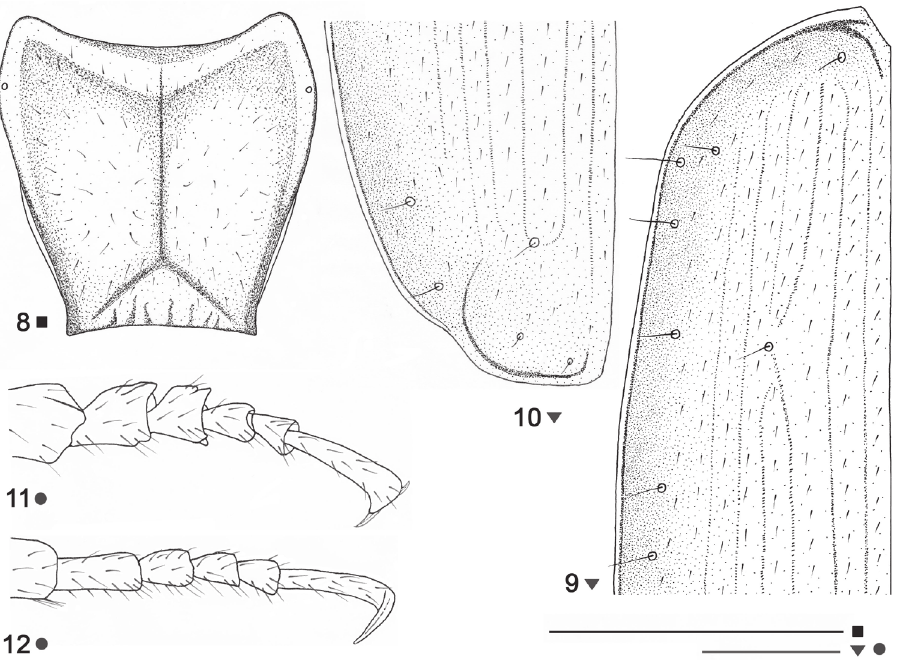
Figures 8–12. Beronaphaenops gen. n. paphlagonicus sp. n. 8 Pronotum, holotype 9 Anterior part of 11, 12 :